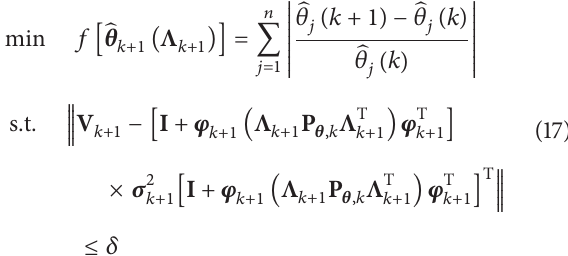
algorithm [32] is used for the process of solving Λ 𝑘+1